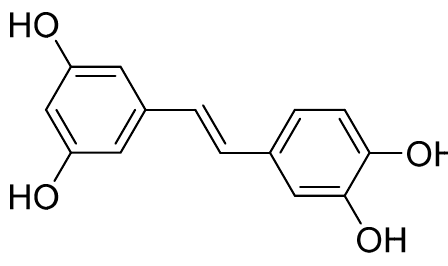
Figure 6. Structure of piceatannol.